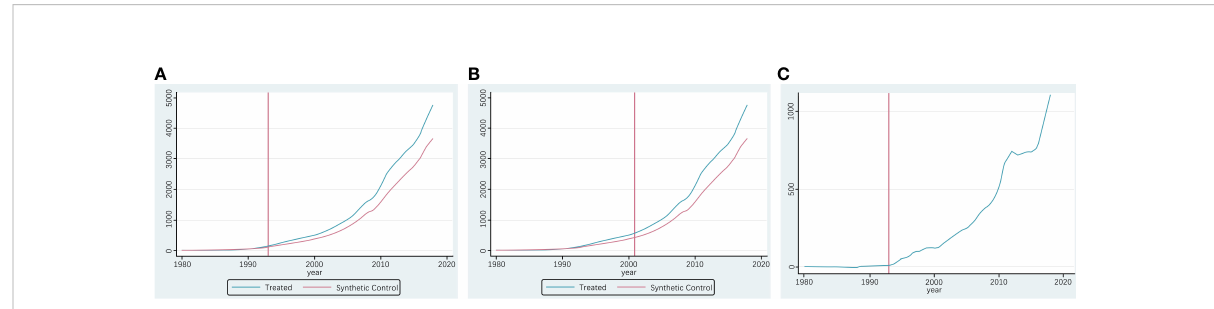
FIGURE 4 Difference in GDP between Xiamen and synthetic Xiamen after two rounds of experiments. (A) GDP of Xiamen city and synthetic Xiamen city after the fi rst round of experiment. (B) GDP of Xiamen city and synthetic Xiamen city after the second experiment. (C) : GDP of Xiamen city and synthetic Xiamen city after the second experiment.